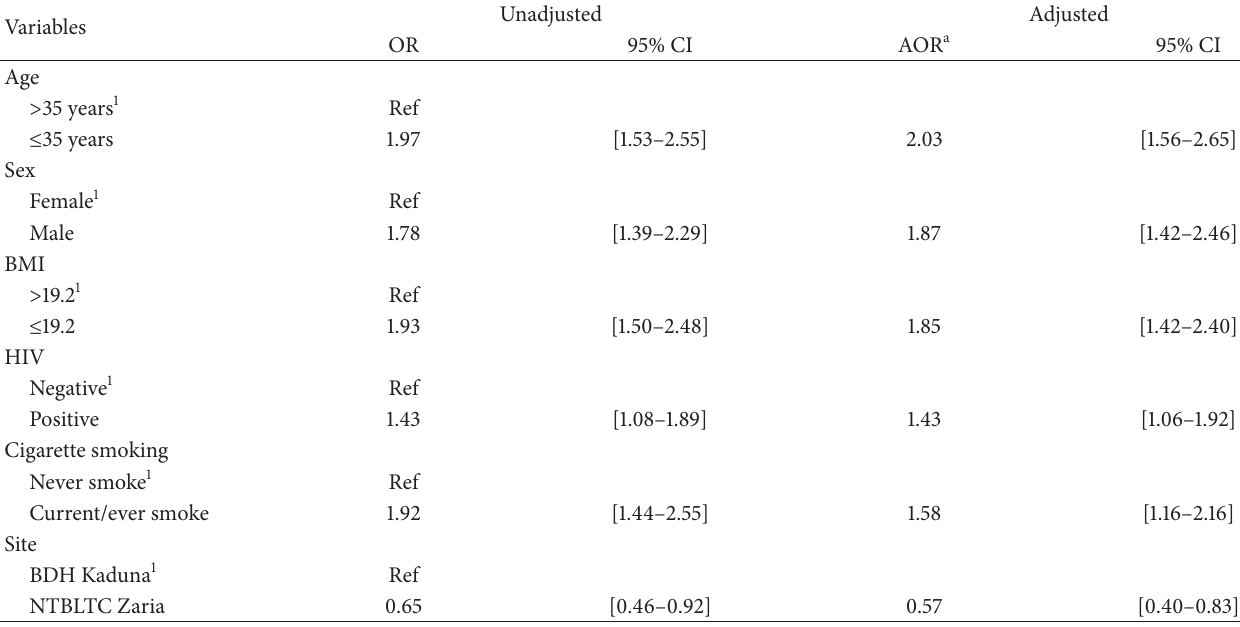
Table 2: Multivariable logistic regression analysis for the risk factors of MTB complex infection among participants receiving care at two TB treatment sites in northern